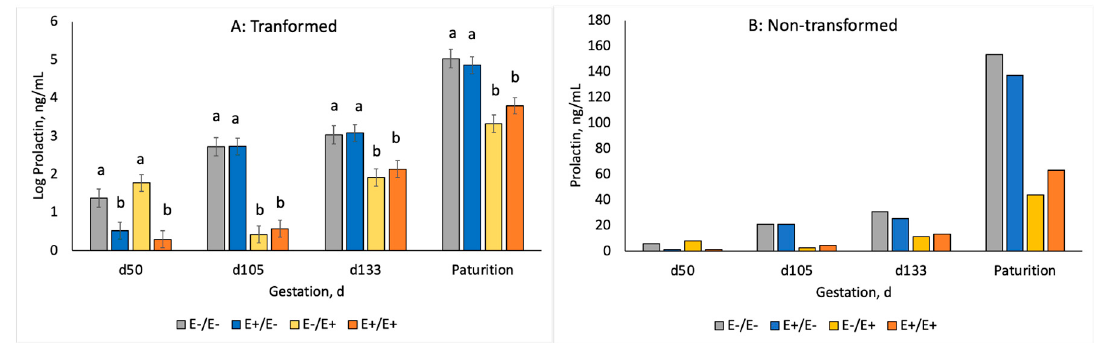
Figure 1. Serum prolactin concentrations, log-transformed for statistical analyses ( A ) or actual means ( B ), in ewes fed E − or E+ fescue seed from d 35 to 85 and/or d 85 to parturition. a,b Superscripts denote differences ( p < 0.05) by day of gestation.